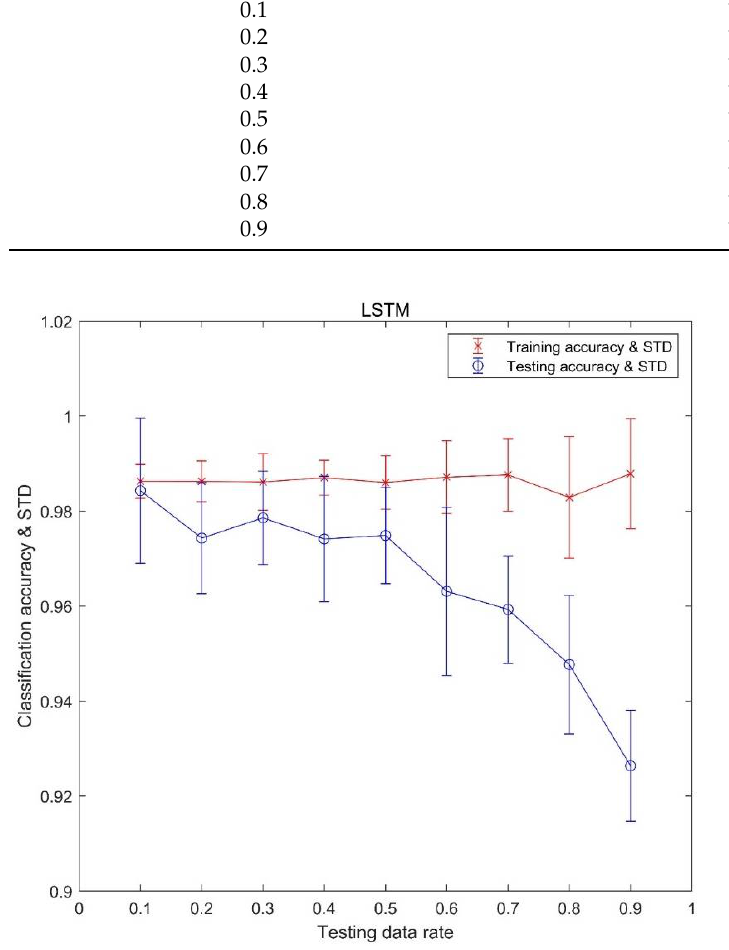
Figure 8. The classification results of training and testing data.